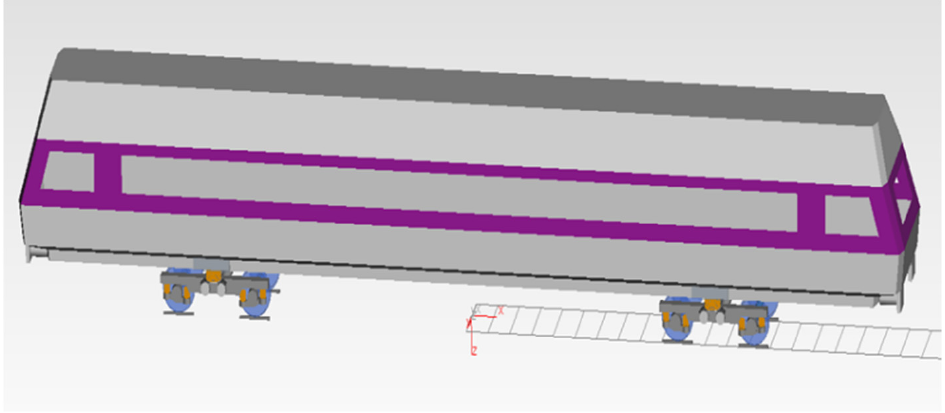
Figure 2. Railway vehicles modeling.